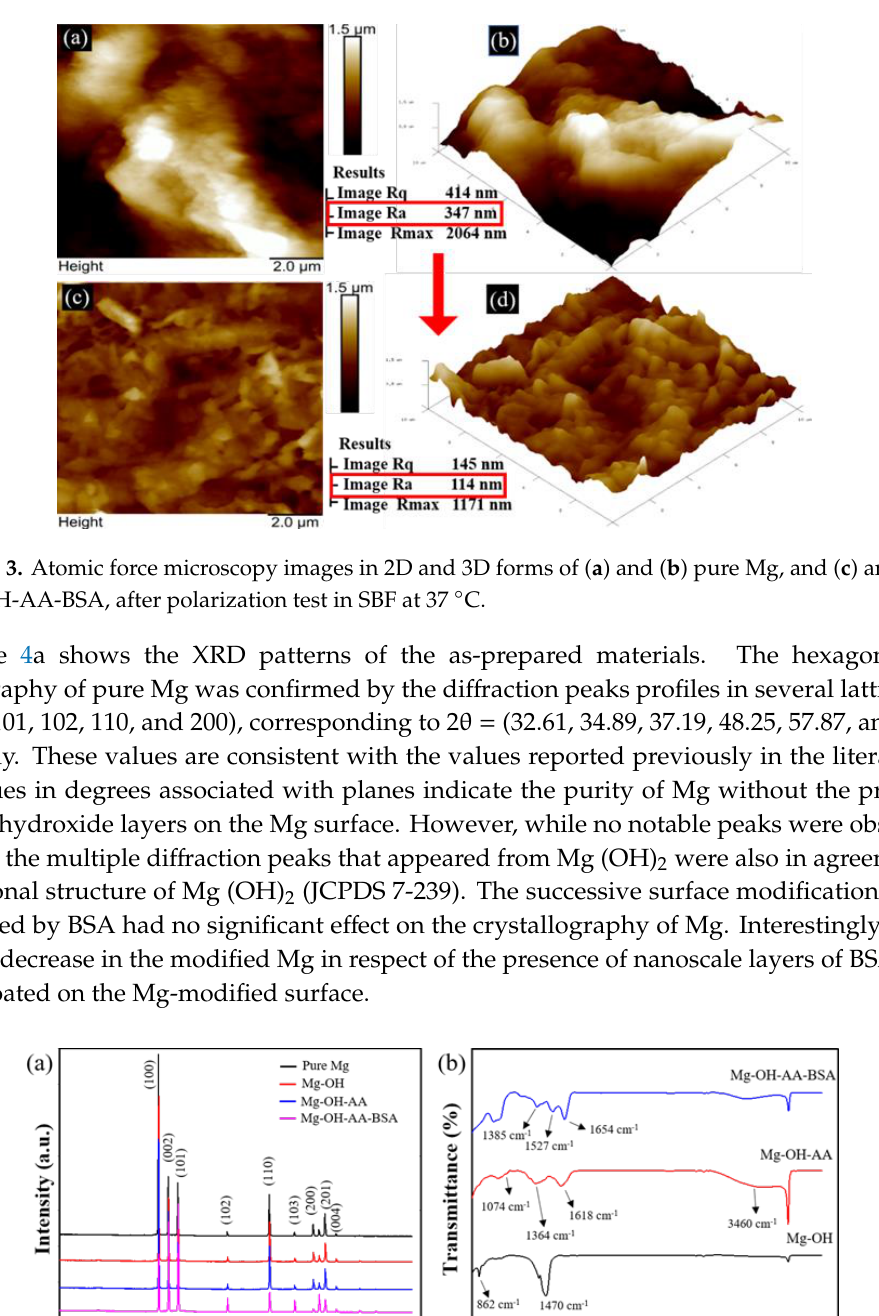
Figure 4. ( a ) XRD analysis of pure Mg and other surface modified Mg samples. ( b ) FT-IR spectra of as-prepared samples surface.